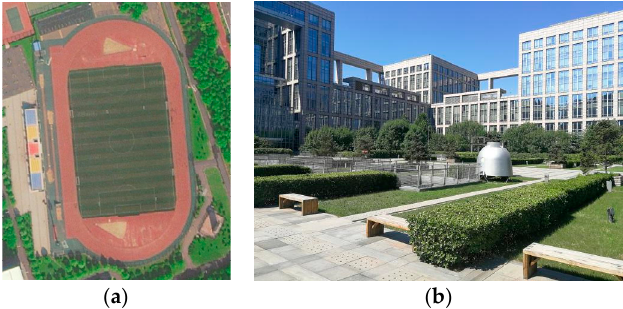
Figure 6. Experimental site. ( a ) The stadium of the Beihang Shahe Campus; ( b ) The central platform of the New Main Building of the Beihang Xueyuan